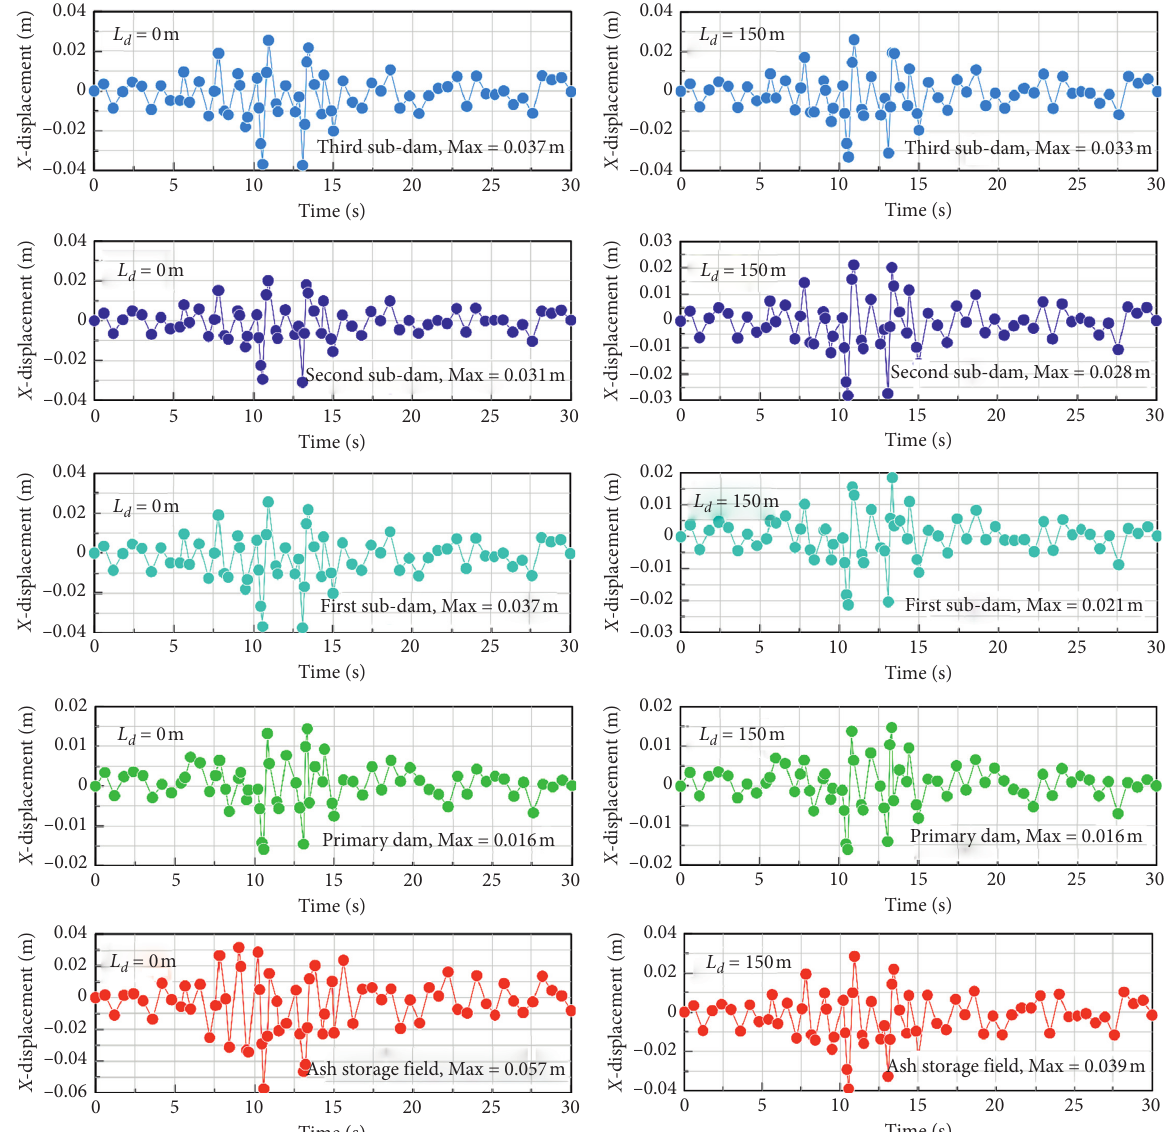
Figure 9: Time-course curves of horizontal displacement of various parts of the ash storage